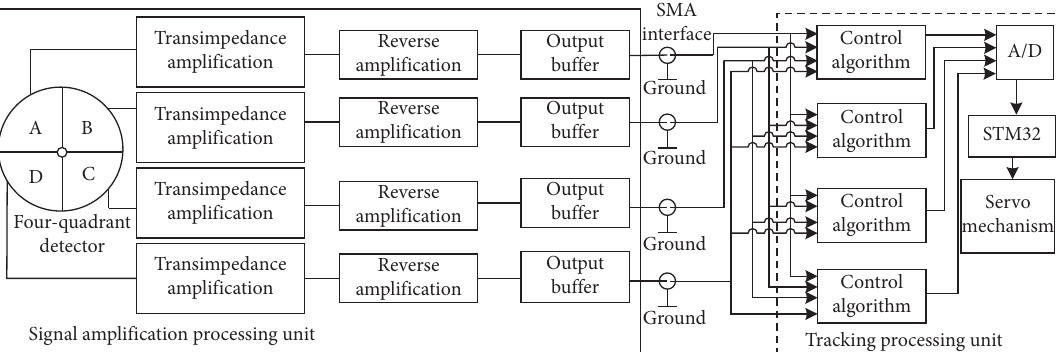
Figure 3: Beam position detection system.